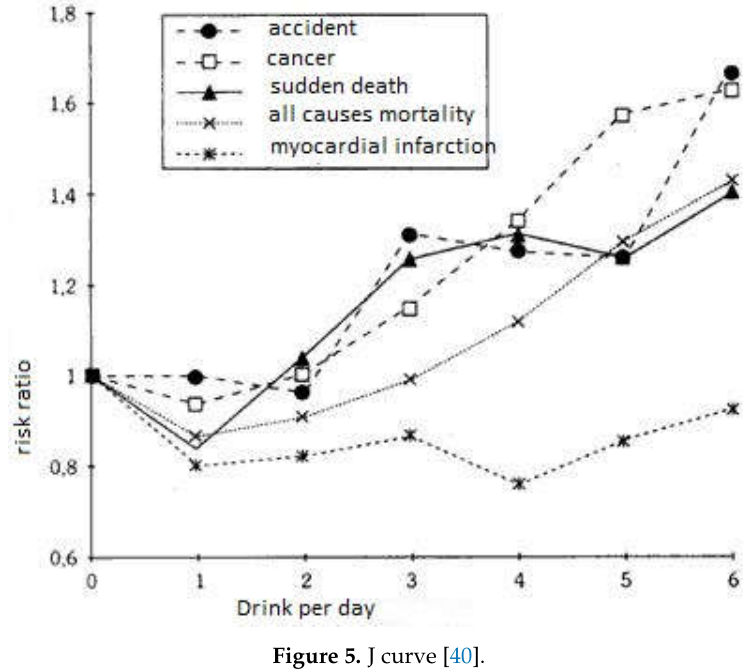
Figure 5. J curve Figure 5. J curve [40].